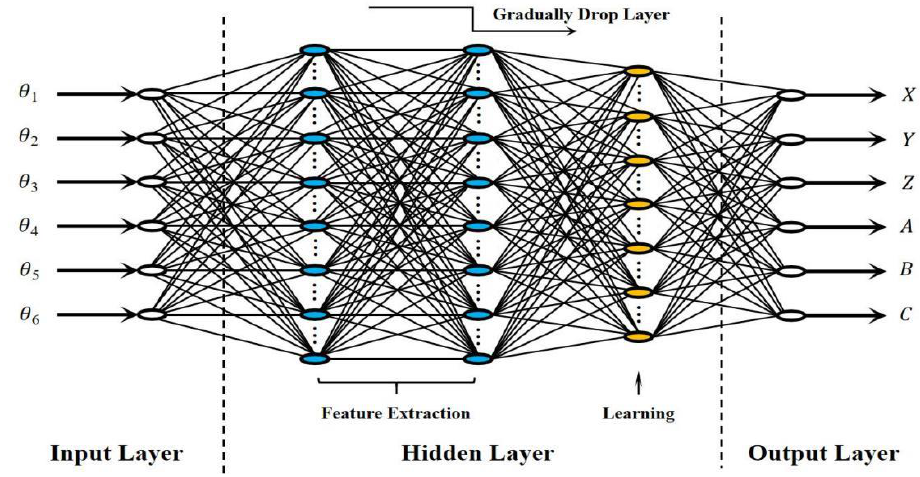
Figure 6. Multi-layer forward propagating neural network structure diagram.